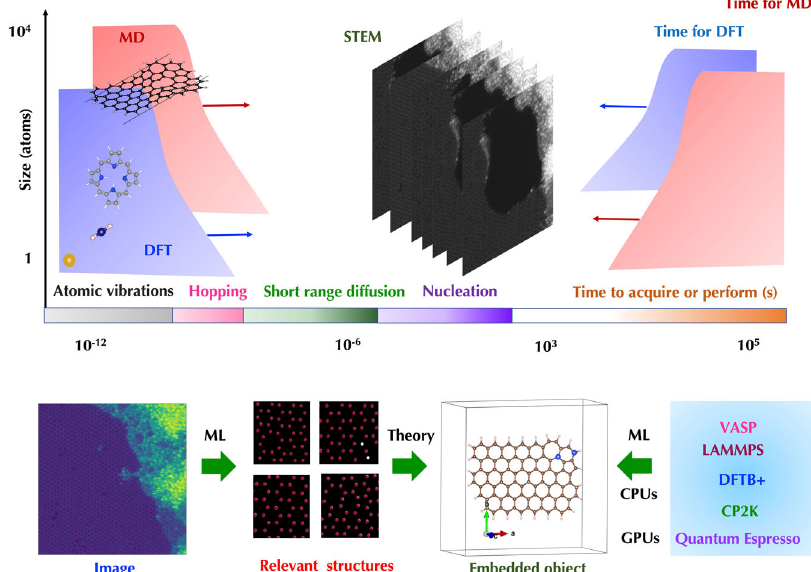
Fig. 1 The time and length scales for imaging and simulations. While DFT and MD can address the system dynamics on the picoseconds to microseconds, electron microscopy generally explores dynamic changes within milliseconds — hours interval. This signi fi cant time disparity is further exacerbated by the fact that the time to complete DFT/MD simulations for a suf fi ciently large system is typically hours or days, way above the imaging time. Hence, dynamic integration of theory and experiment in a single work fl ow necessitates the use of machine learning both to identify (based on observations) the regions of potential interest and to accelerate simulations via proxy models and theory to de fi ne proper embeddings that preserve the functionality of material in small number of atom